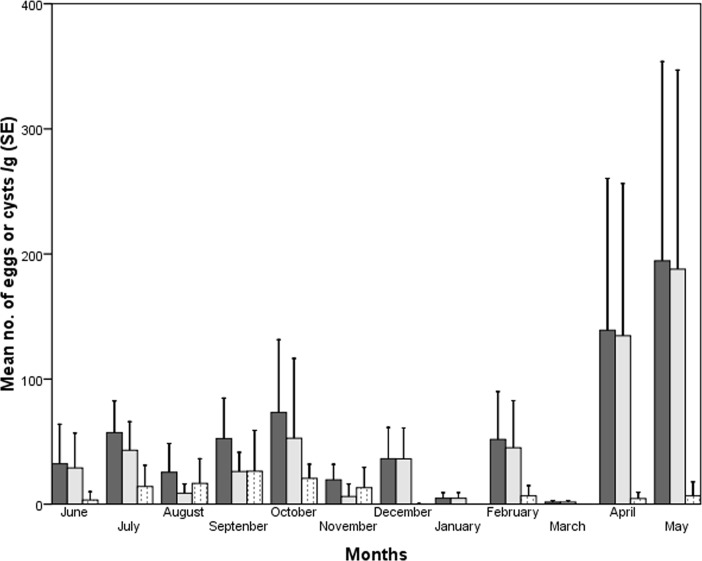
Mean egg/cysts load in fecal samples of bonnet macaque across different months (dark gray: Overall load; light gray: Helminth load; dotted: Protozoan load).